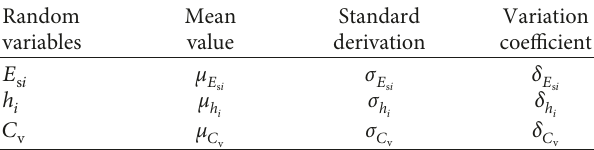
Table 2: The statistics of E